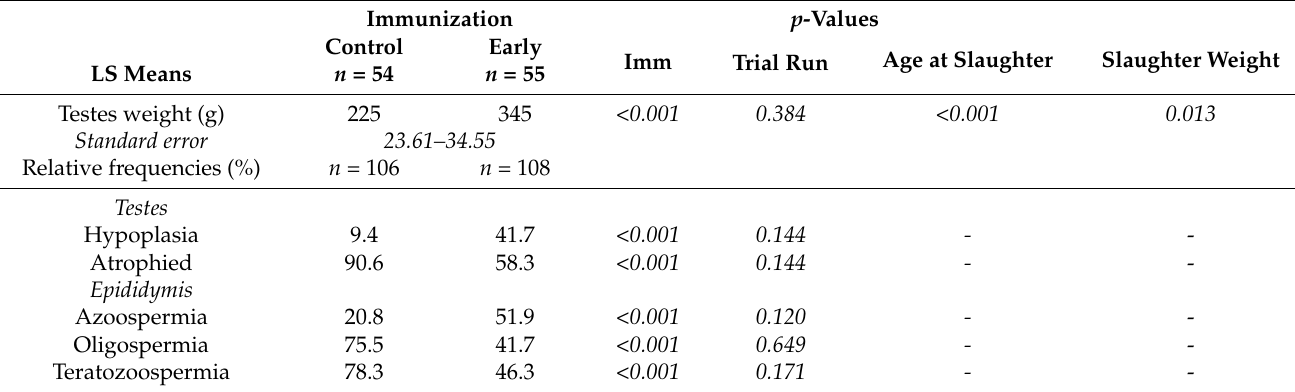
Table 1. Testes weight and development according to immunization scheme.